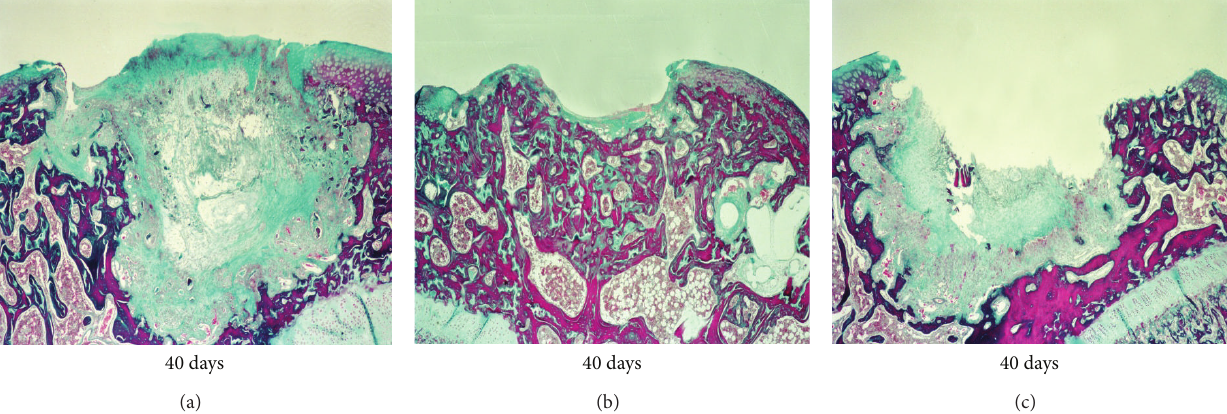
Figure 2: The results of specimen Masson staining in restoration area; magnification times of all pictures in Figure 2 are 200. Pictures (a), (b), and (c) belong to groups A, B, and C,